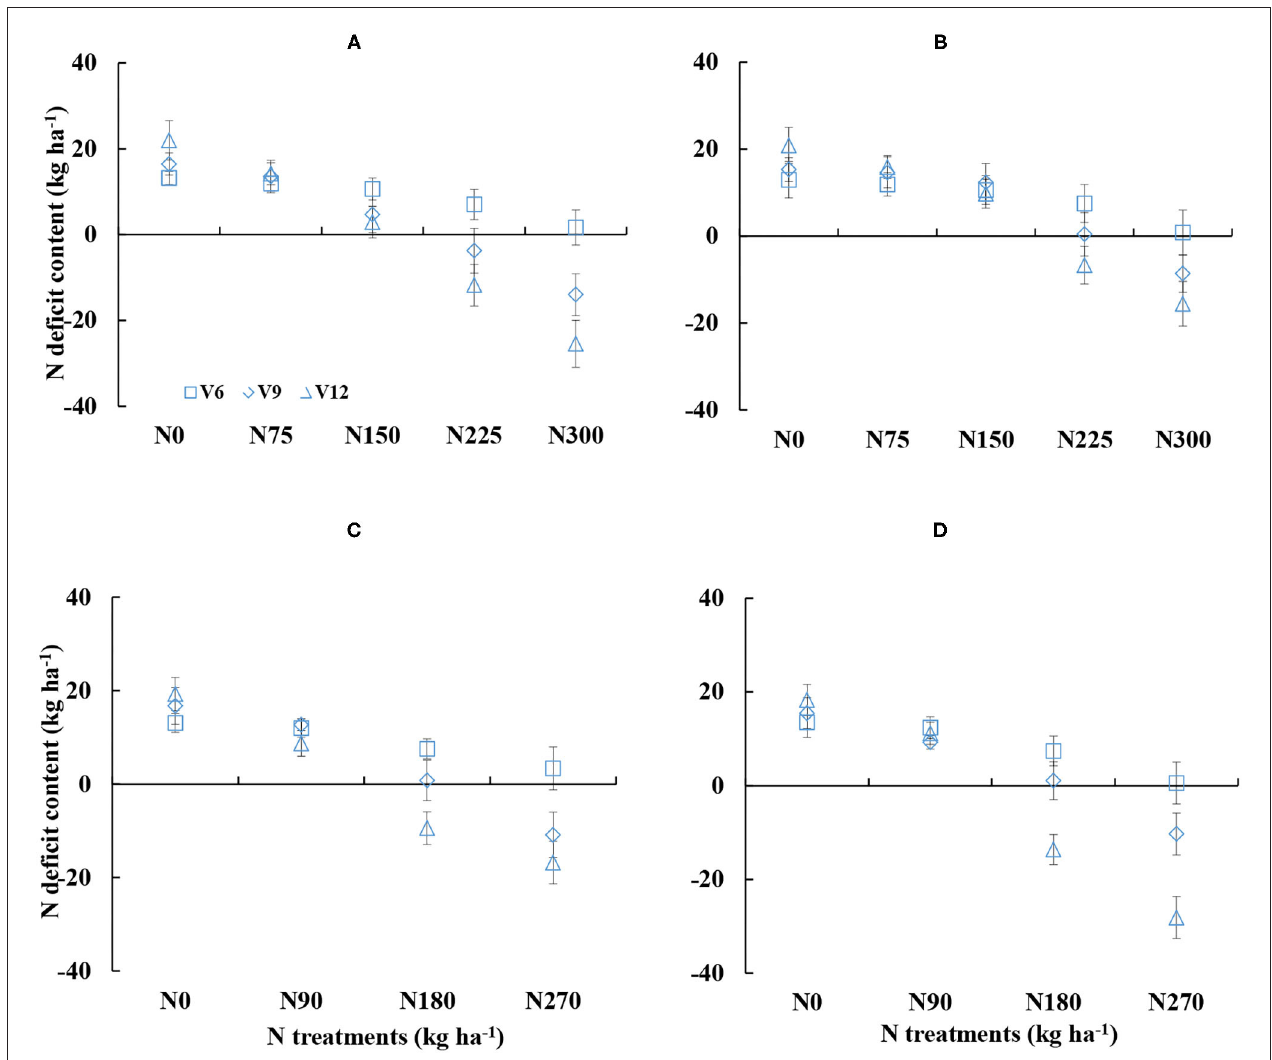
FIGURE 3 | Dynamic changes in the nitrogen deficit content (NDC) under various nitrogen (N) application rates from V6 to V12 growth stages of corn ( A : 2015 DY919; B : 2015 JD20; C : 2016 DY919; D : 2016 JD20. V6, V9, and V12 represent the sixth, ninth, and twelfth leaves, respectively).